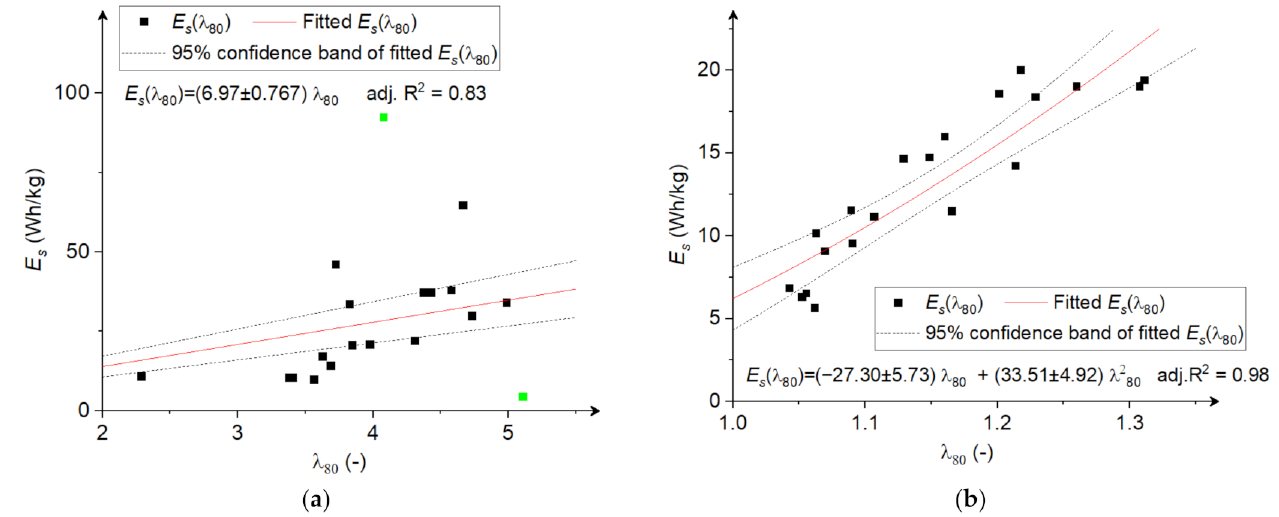
Figure 4. The dependence between size reduction ratio and specific comminution energy: ( a ) corn grains; ( b ) rice grains. The green points are outliers and not included in the